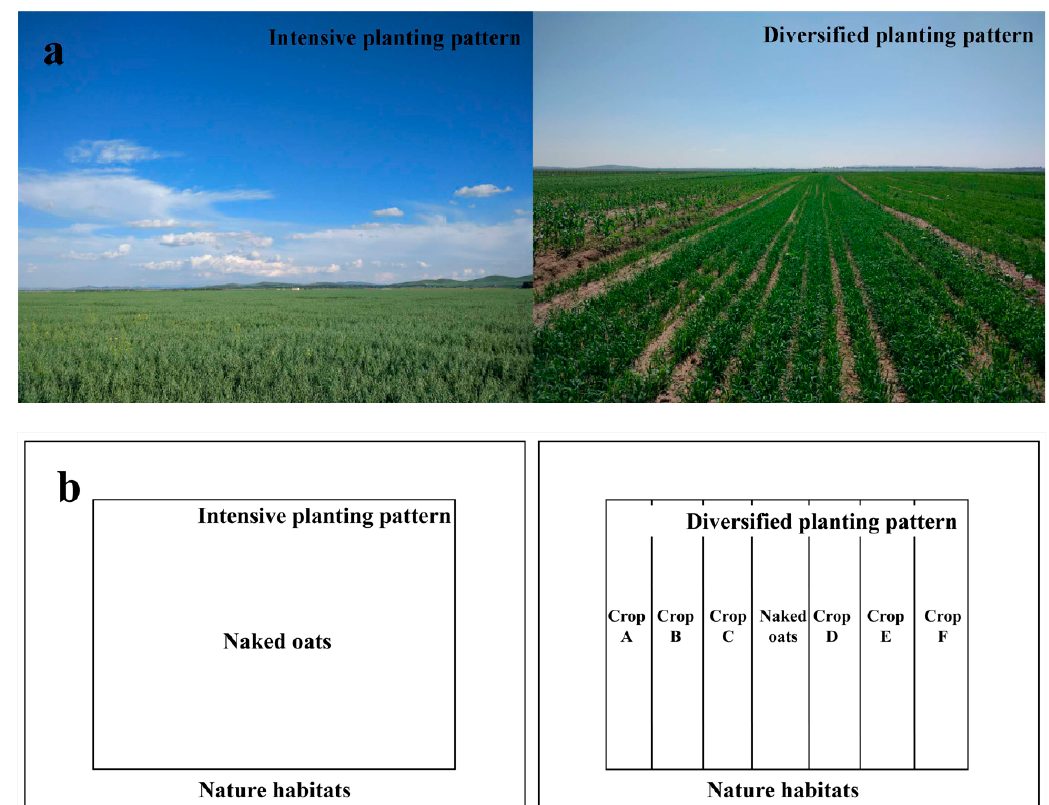
Figure 2. Schematic figures showing naked oat under different planting patterns: ( a ) pictures of naked oat fields; and ( b ) schematic diagrams of naked oat fields.